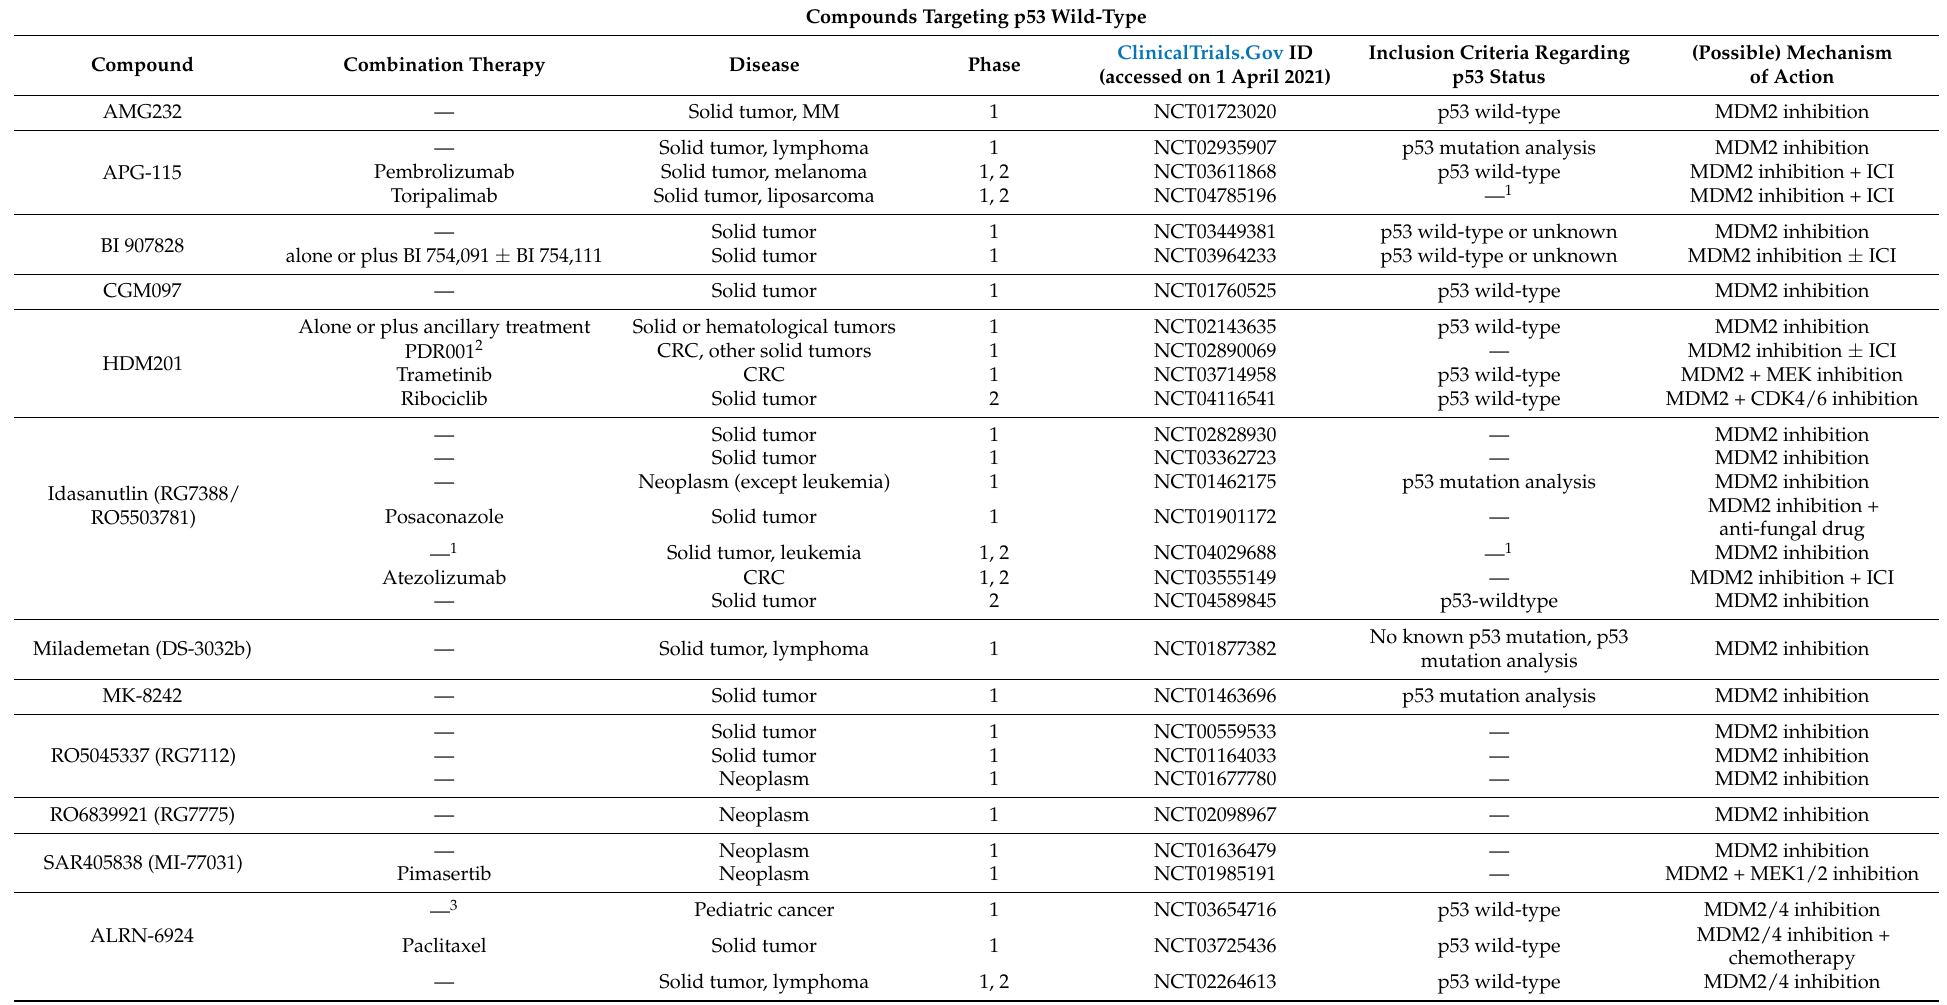
Table 1. Overview of compounds targeting wild-type or mutant p53 in clinical trials in colorectal cancer or solid tumors (not specified). DN, dominant-negative; HLA, human leukocyte antigen; ICI, immune checkpoint inhibition; ID, identifier. IHC, immunohistochemistry; MM, multiple myeloma; TCR, T cell